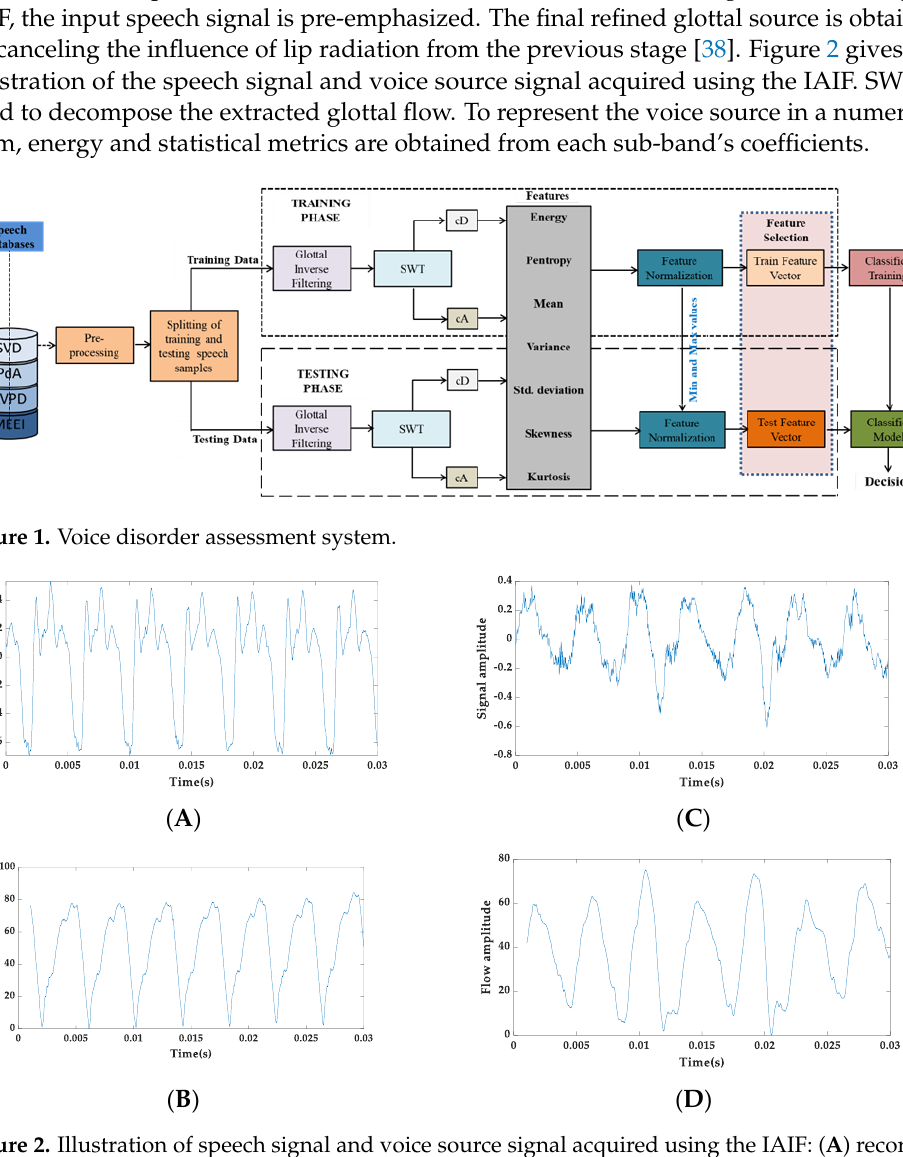
Figure 2. Illustration of speech signal and voice source signal acquired using the IAIF: ( A ) recorded healthy speech signal, ( B ) glottal flow signal of healthy speech, ( C ) recorded pathological speech signal, and ( D ) glottal flow signal of pathological speech.